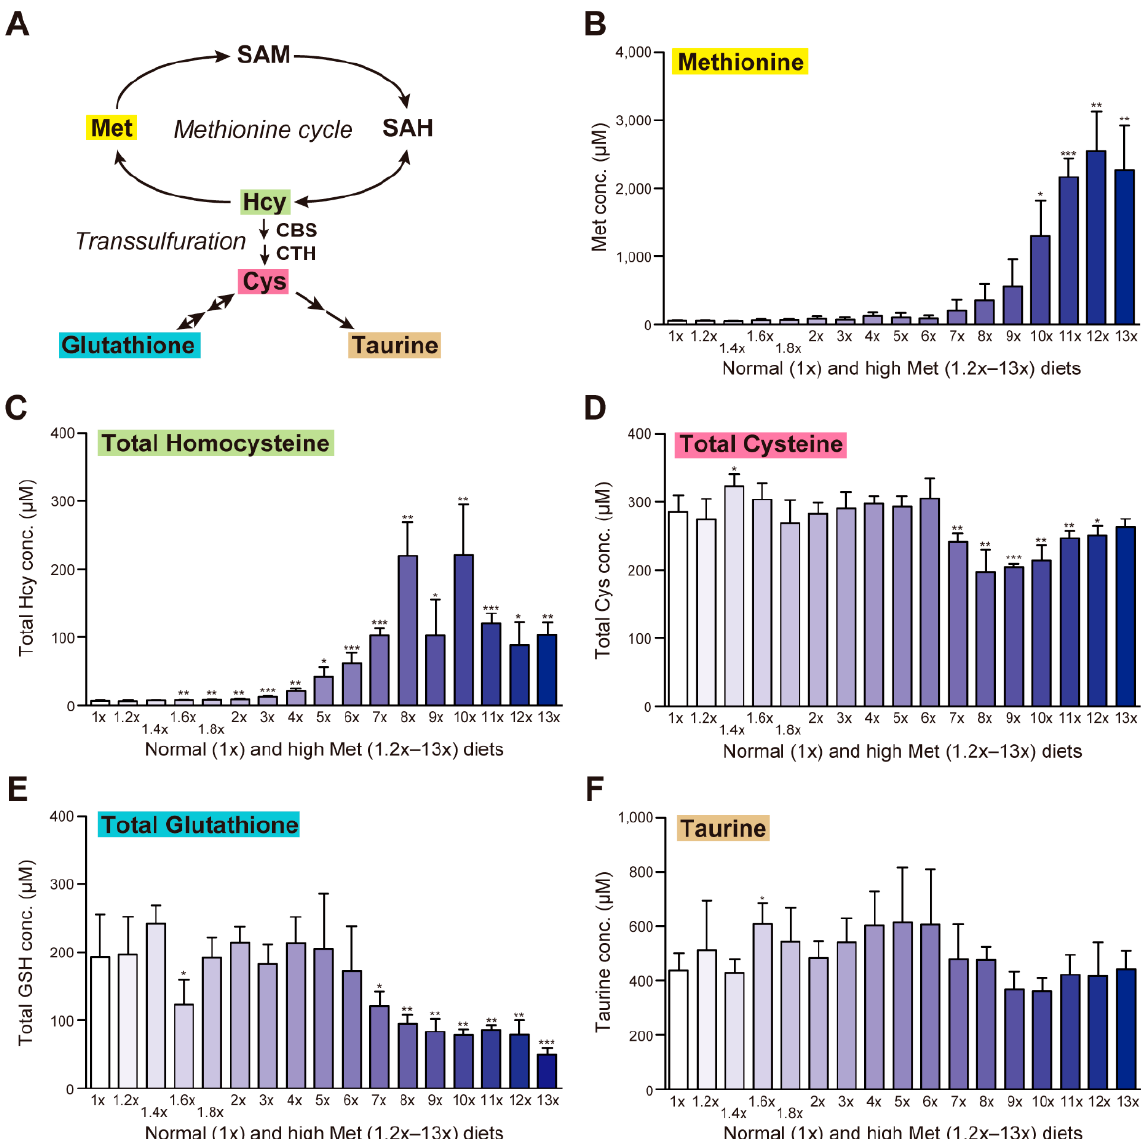
Figure 2. Impact of one-week high-methionine (Met) diet on serum levels of Met and cysteine (Cys) metabolites. ( A ) Schematic representation of the Met metabolic pathway (Met cycle, transsulfuration, and Cys metabolism) in mammals. ( B – F ) Adult C57BL/6J male mice were ad libitum fed a standard CE-2 rodent diet (0.440% Met) until 8–9 weeks of age and then fed CE-2 (1×Met) or CE-2 containing graded concentrations of Met (1.2×Met [0.528%]–13×Met [5.72%]) for a week. Serum levels of Met ( B ), total homocysteine ( C ), total Cys ( D ), total glutathione ( E ), and taurine ( F ) were measured using HPLC. Data are the mean ± SD ( n = 8 for 1×Met and 6×Met and n = 4 for the others). The differences versus 1×Met samples were significant at * p < 0.05, ** p < 0.01, and *** p < 0.001 in the Student’s t -test.